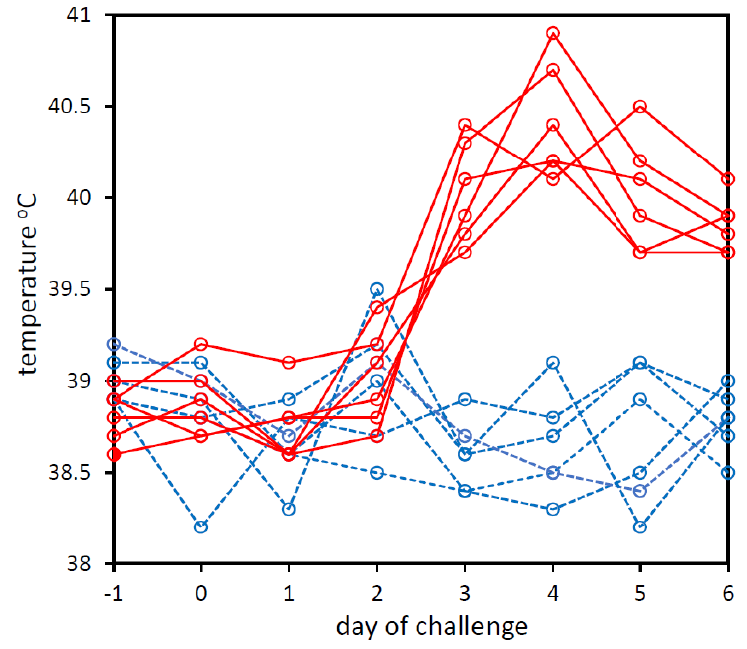
Figure 1. Rectal temperatures of calves that were experimentally challenged with PBS (dashed blue line) or BoHV-1 (solid red line). Temperatures on day − 1 pre-challenge to day 6 post-challenge are